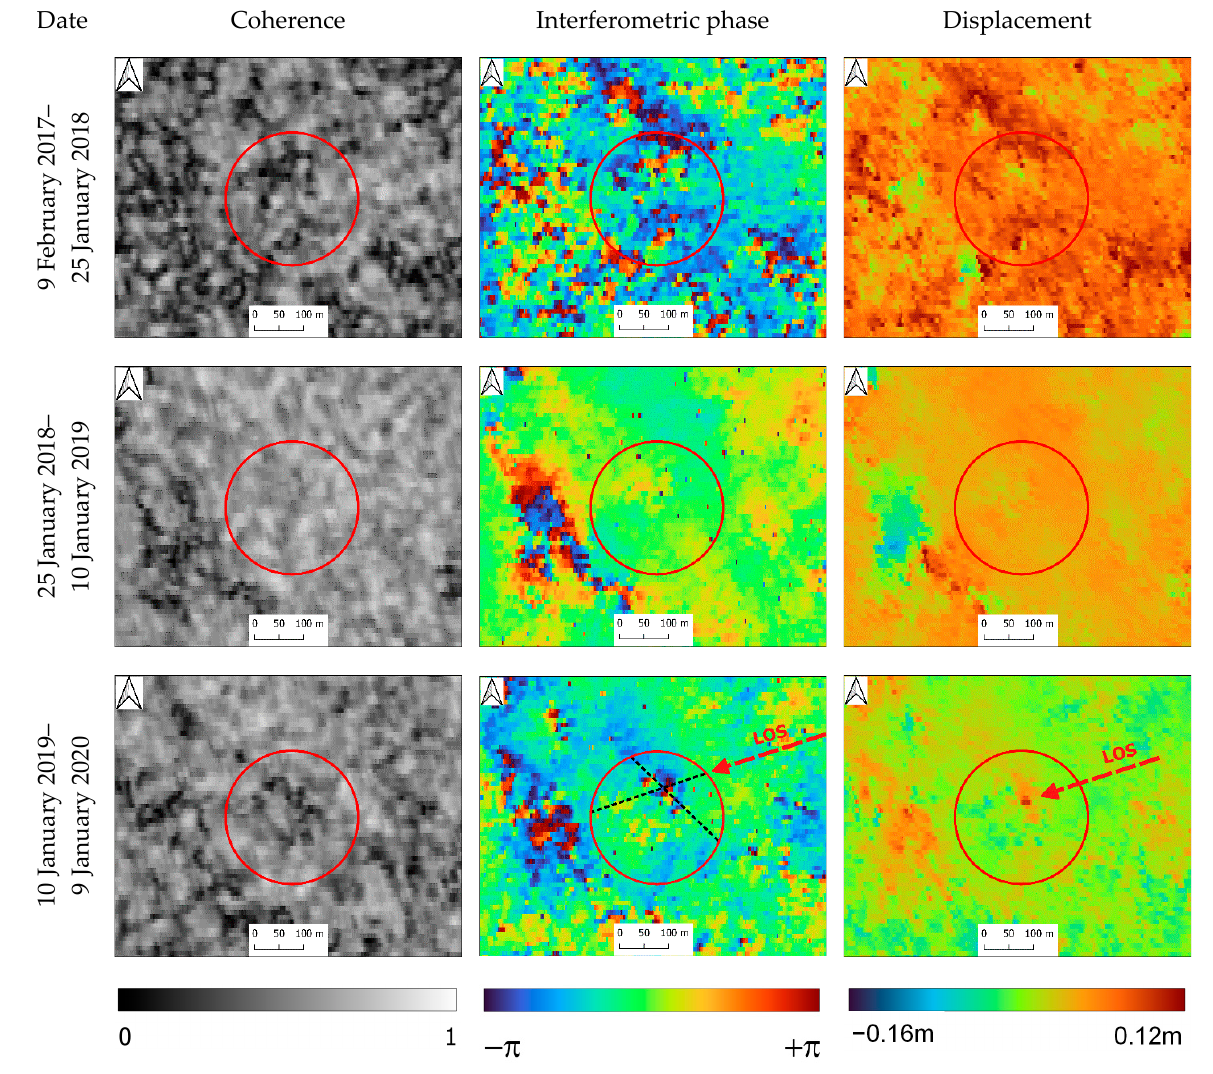
Figure 6. Fragments of coherence, interferograms, and displacement maps for the area with PHM. The coherence inside the outline for the third interferometric pair, 10 January 2019–9 January 2020, is lower than 0.2 only for several pixels. These low ‐ coherence areas only partially intersect with a small (2–3 pixel wide) interferometric fringe (i.e., PHM), which is indicated by the red arrow. This arrow shows the direction of the line of sight as well.